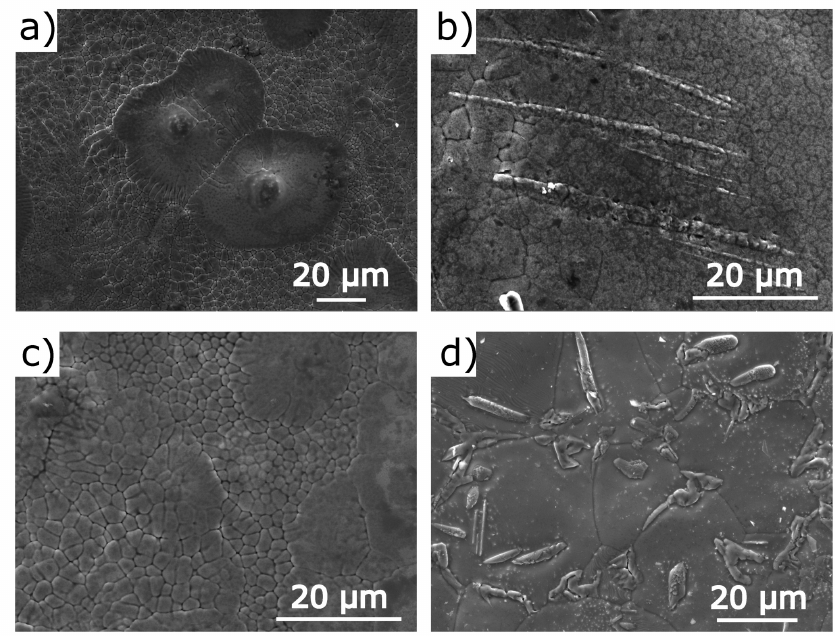
Figure 1. Microstructure of Ni 50 − x Co x Mn 35.5 In 14.5 ribbons at RT: Ni 47 Co 3 Mn 35.5 In 14.5 as-spun ( a ) and annealed ( b ) ribbons; Ni 45 Co 5 Mn 35.5 In 14.5 as-spun ( c ) and annealed ( d )